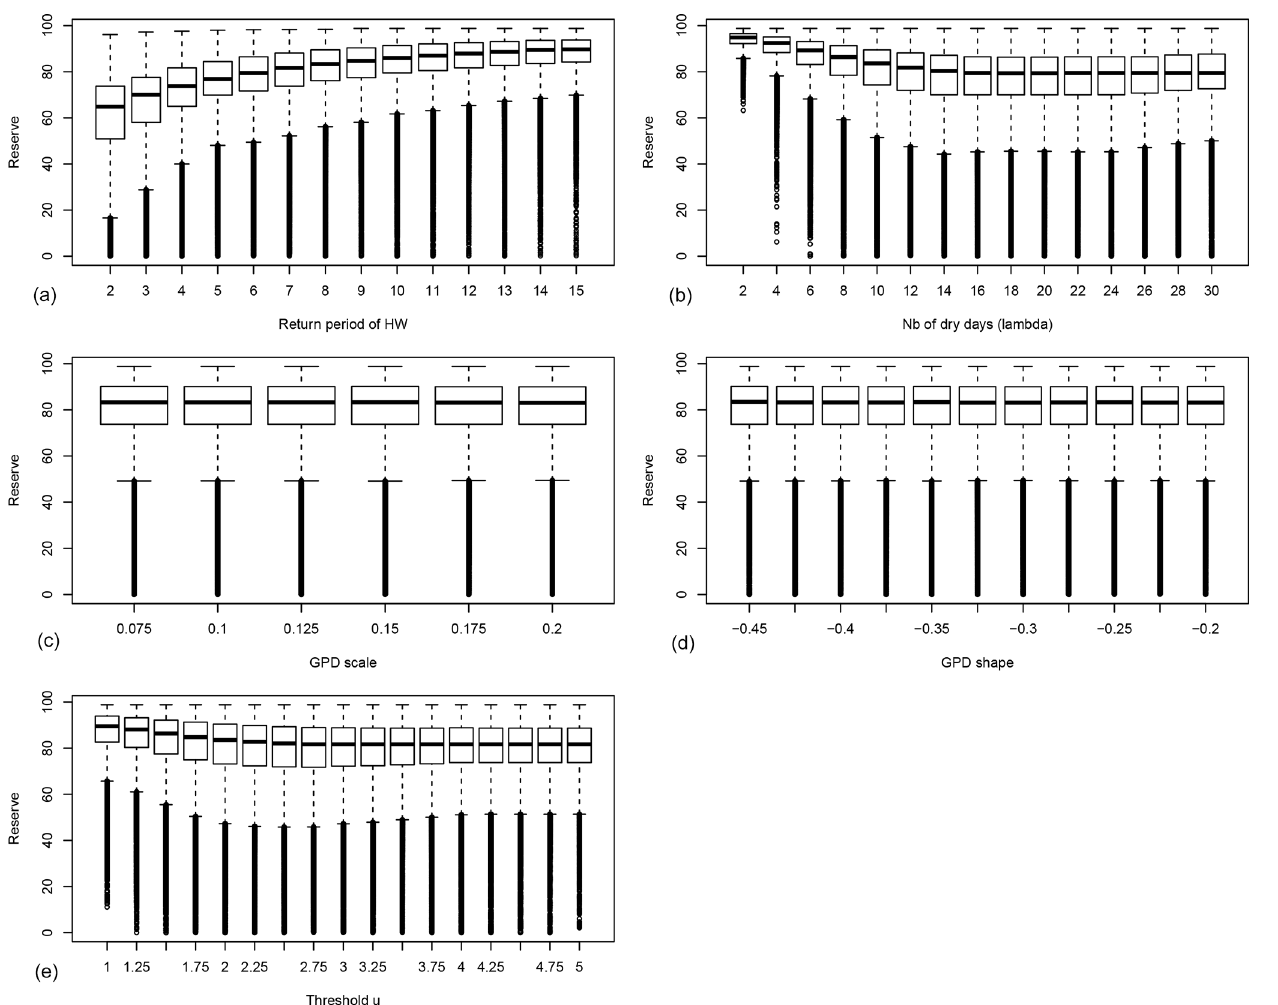
Figure 3. Probability distribution of the average reserves before ruin (cid:104) R (cid:105) as functions of the drought–heatwave (HW) return period (cid:51) (a) , number of hot days during summer λ (b) , GPD fit scale σ (c) , GPD fit shape ξ (d) and the GPD threshold u (e) . B = 0 in all experiments. For each value of the control variable, a boxplot is given. The thick horizontal bar in each box represents the median ( q 50) of the distribution. The boundaries of each box represent the 25th quantile ( q 25) and the 75th quantile ( q 75). Each upper whisker represents min [ max( (cid:104) R (cid:105) ) , 1 . 5 × ( q 75 − q 25) + q 50 ] . Each lower whisker has the symmetric formulation. Small circles represent data that are above or below the whiskers; note that the circles below the lower whiskers tend to be close to each other and therefore appear like thick vertical lines.